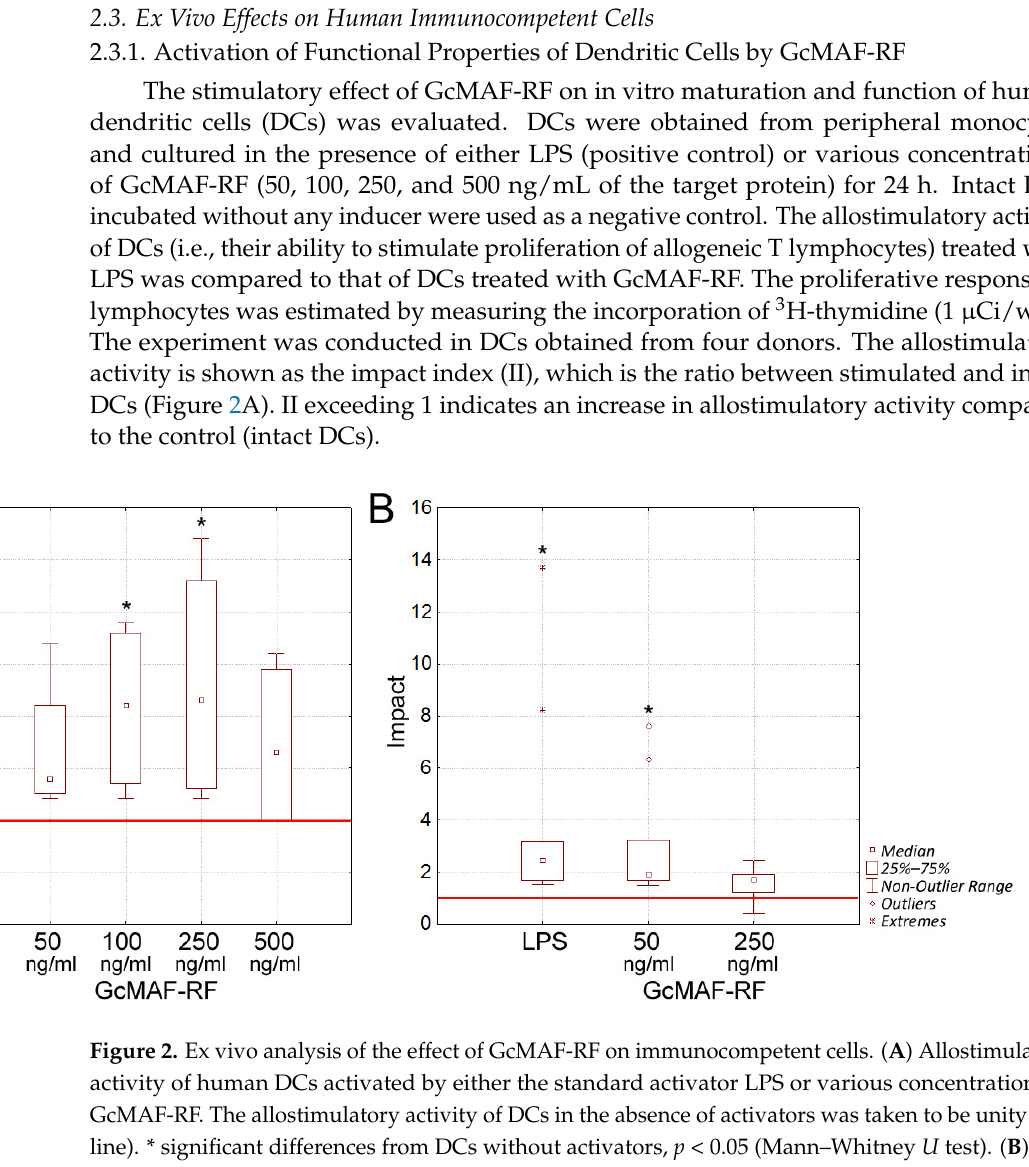
maturation of DCs from four independent donors in four independent experiments. 2.3.2. M1 Polarization of M0 Macrophages by GcMAF-RF We assessed the stimulatory effect of GcMAF-RF on M1 polarization of GM–CSF- treated macrophages in vitro. LPS is known to stimulate the polarization of macrophages to the M1 phenotype, which plays an important role in anti-tumor defense [42]. One of the functional hallmarks of M1 cells is their high allostimulatory activity. In this study, we performed a compara- tive assessment of the effects of GcMAF-RF and LPS on the allostimulatory activity of GM–CSF-differentiated (unpolarized) macrophages. Peripheral blood monocytes were grown in the presence of GM–CSF and further ex- posed to either LPS or GcMAF-RF (50 and 250 ng/mL) for 48 h. Intact GM–CSF-maturated mononuclear cells (MNCs) were used as a negative control. Macrophages were cultured with allogeneic MNCs for evaluating their allostimulatory activity. The proliferative re- sponse was estimated on day 5 by measuring the incorporation of 3 H-thymidine (1 μ Ci/well). GM–CSF-maturated macrophages from three different donors and MNCs from three other different donors were used in the experiments. As a result, nine independent combinations were obtained. The allostimulatory activity is shown as the II, which is the